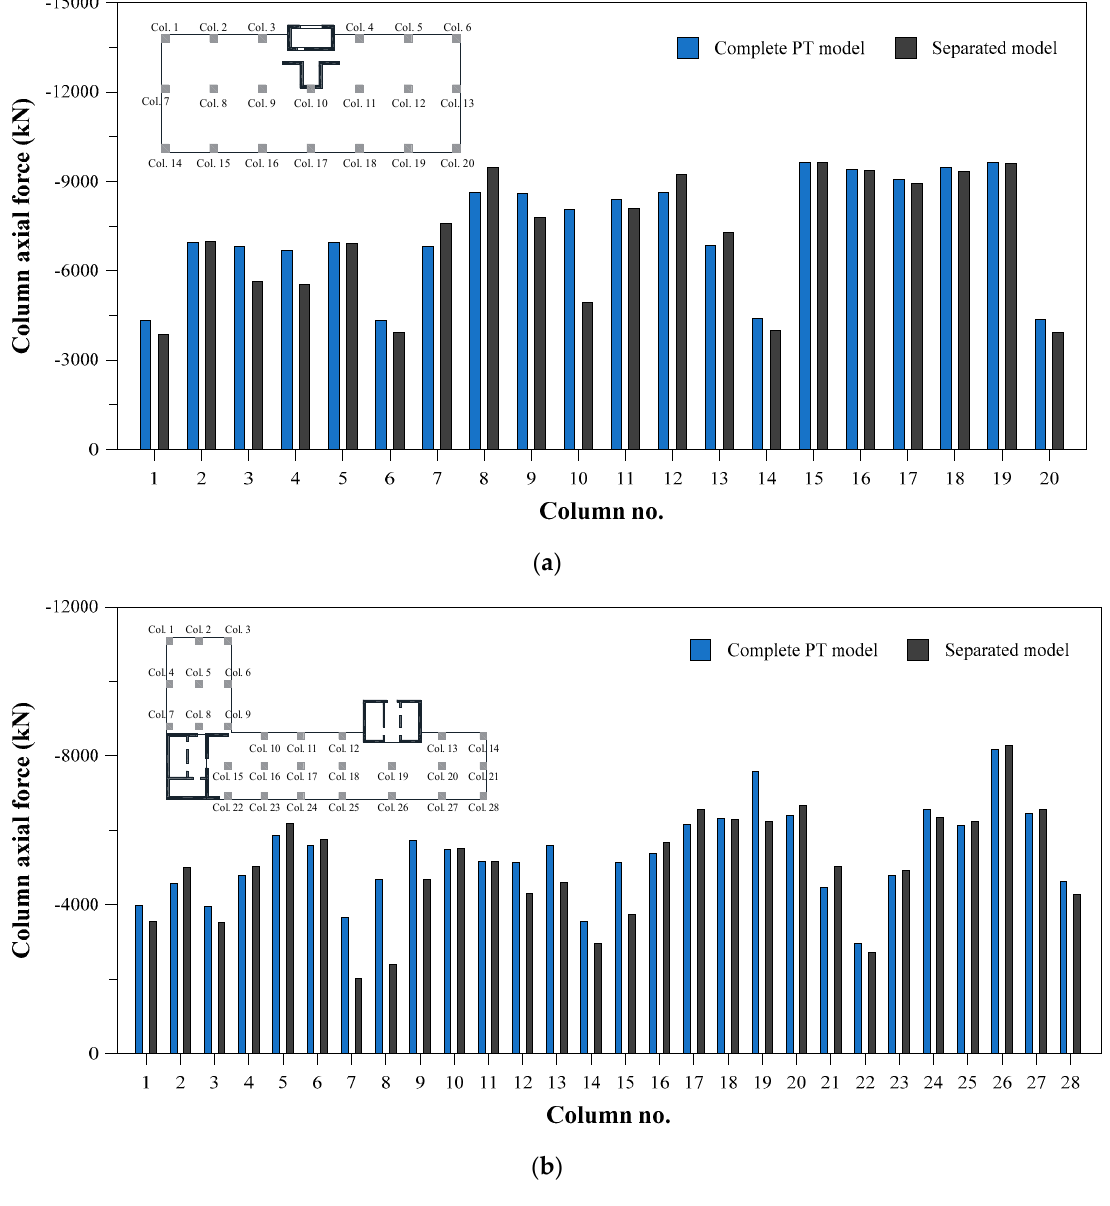
Figure 9. Comparison of column axial force under gravity load according to the modeling method (without load transfer through core walls), ( a ) Flat-shape plan, ( b ) L-shape plan. For the Flat-shape plan, the difference between the axial forces of the separated model and the complete model ranged from 61% to 111%. At the corner columns, it was about 10% lower, and at the exterior columns, it was lower by more than 10%. Where columns were close to the core walls, the difference was more remarkable. Although Col. 2, 5 and 15 to 19 were exterior columns, there were few differences in axial force. However, at Col. 3, 4 and 10, which is relatively close to the core wall, differences noted were more than 18%. Meanwhile, in the L-shape plan, the axial force of the separated model was calculated as 51% to 113% of the complete model. At the corner columns, it was up to 17% lower than the complete model, and at exterior columns, it was up to 49% lower. As in the Flat-shape plan, significant differences were observed in columns near the core wall. The axial forces of Col. 10, 11 and 23 to 27 in the separated model differed by less than 5% from the complete model. Whereas, Col. 7 to 9, 12, 13, 15, 19 and 22 were 10% and up to 51% lower. A comparison of axial forces for the two plan shapes indicated that the current separated analysis model underestimates axial force on transfer columns near the core